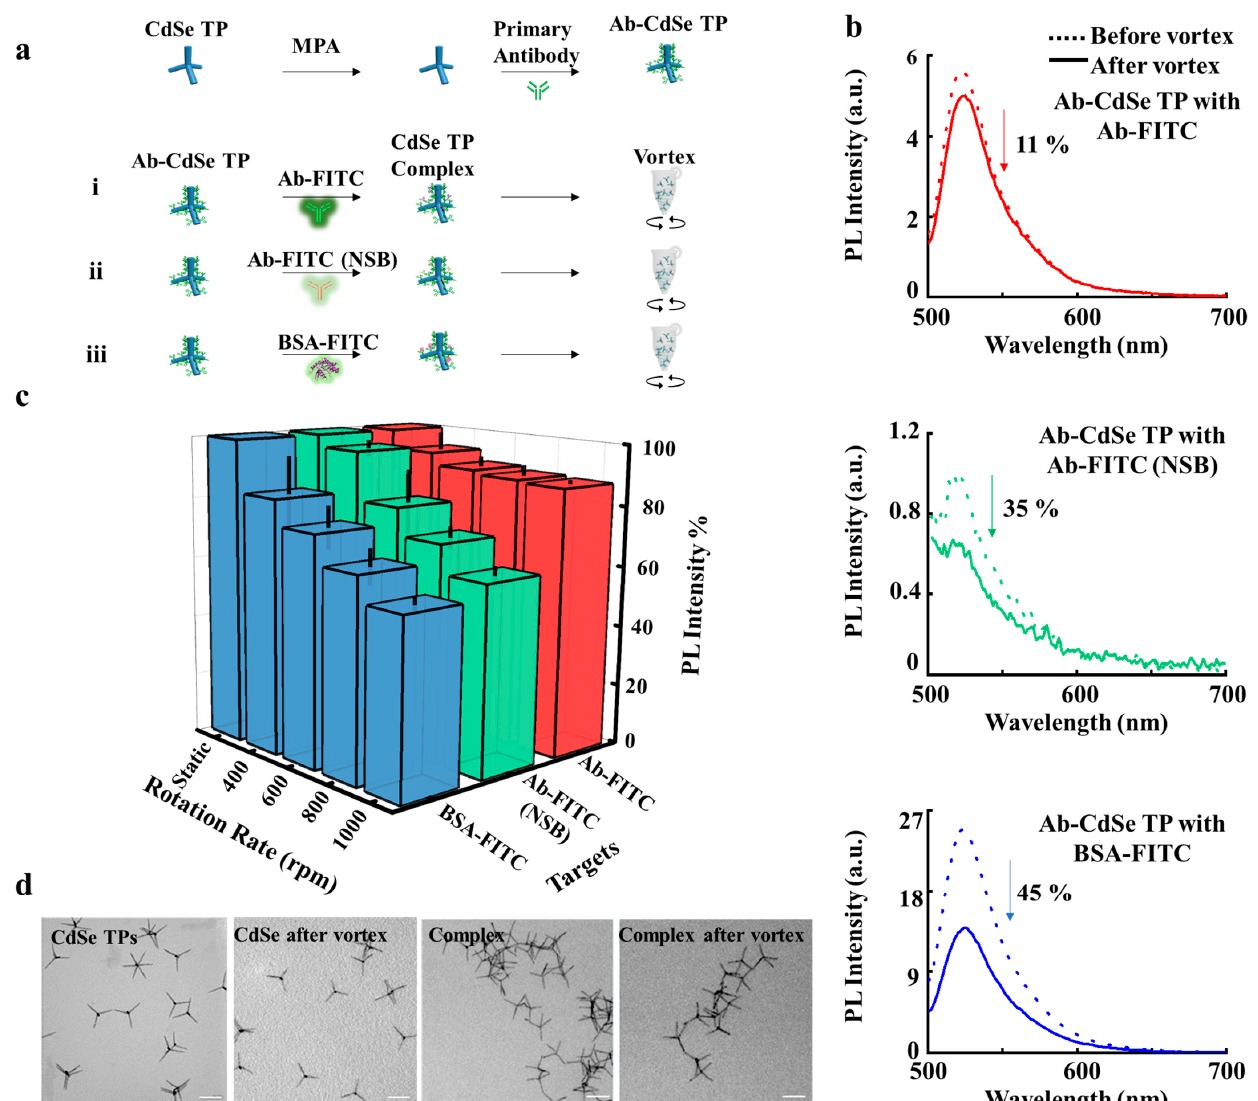
Figure 1. CdSe TP complexes with various proteins under vortex flow. ( a ), Schematic of the CdSe TPs functionalized with the primary antibodies, binding with anti-goat IgG antibody, anti-mouse IgG antibody, and BSA, respectively. The CdSe TP complexes before and after rotation was used for the photoluminescence signal analysis. ( b ), PL intensities of the CdSe TP complexes including the anti-goat IgG antibody ( top ), anti-mouse IgG antibody ( middle ), and BSA ( bottom ) before and after rotation. ( c ), PL intensities as a function of the rotation rate, including 0, 400, 600, 800 and 1000 rpm, respectively. The average values are based on data collected from more than 3 samples prepared independently; the error bar represents the standard deviation of the PL intensity data. ( d ), TEM images of the CdSe TPs before and after the vortex flow. Scale bar, 100 nm.